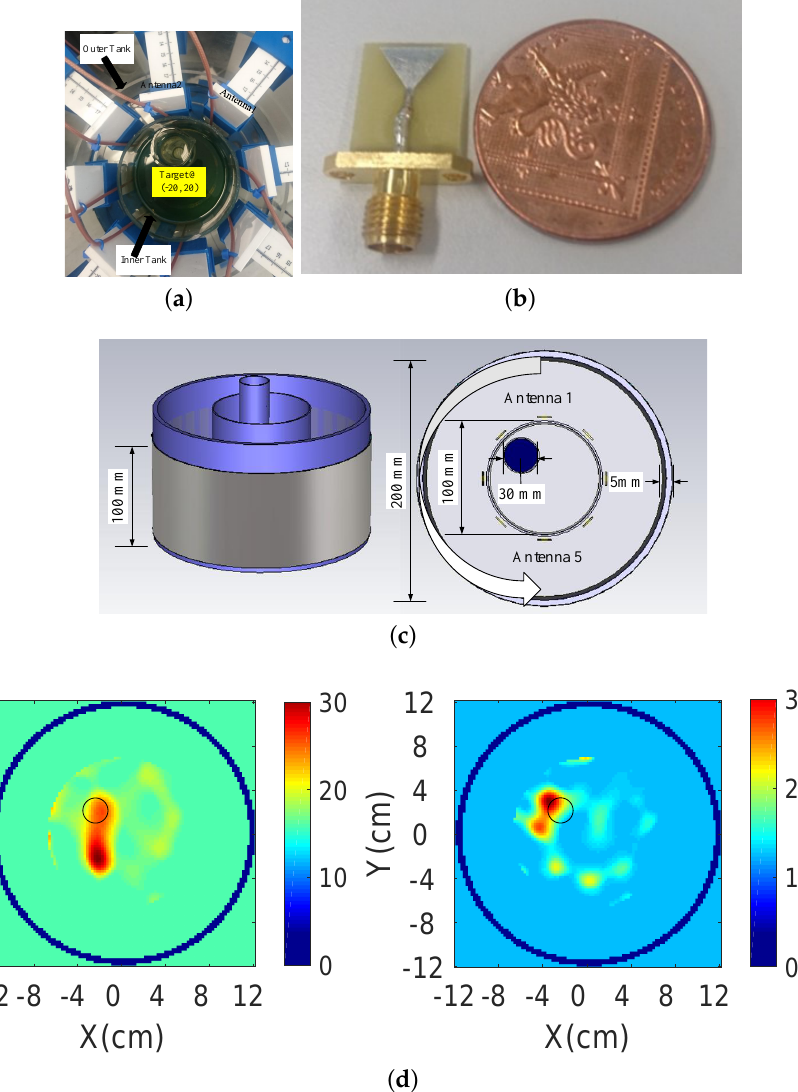
Figure 1. Overview of our employed microwave tomography (MWT) system. ( a , b ) Photos of the experimental measurement prototype and the antenna element; ( c ) Schematic of the MWT system with the cylindrical target inside the tank; ( d ) Reconstructed dielectric constant (cid:101) (cid:48) for a cylindrical target filled with water, using experimental data at: (left) 1.0 GHz, and (right) 1.5